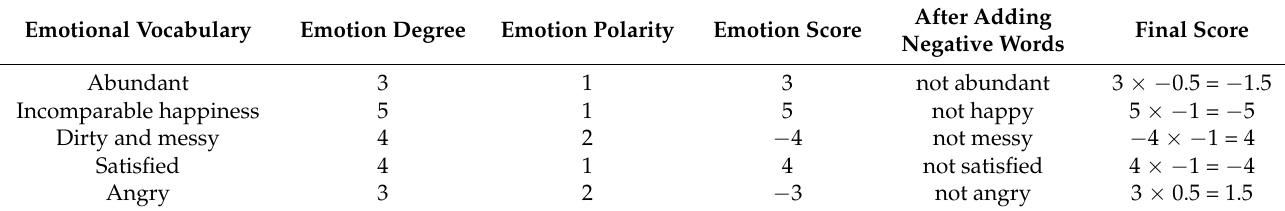
Table 1. Example of Emotion